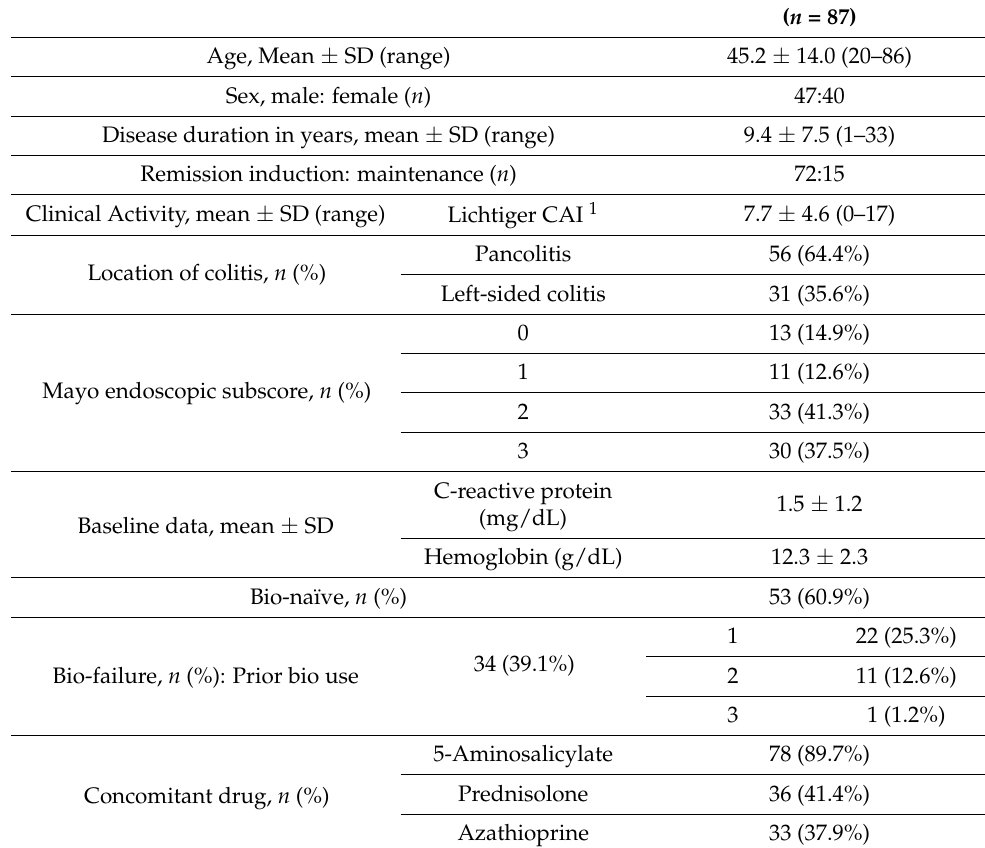
Table 1. Patient